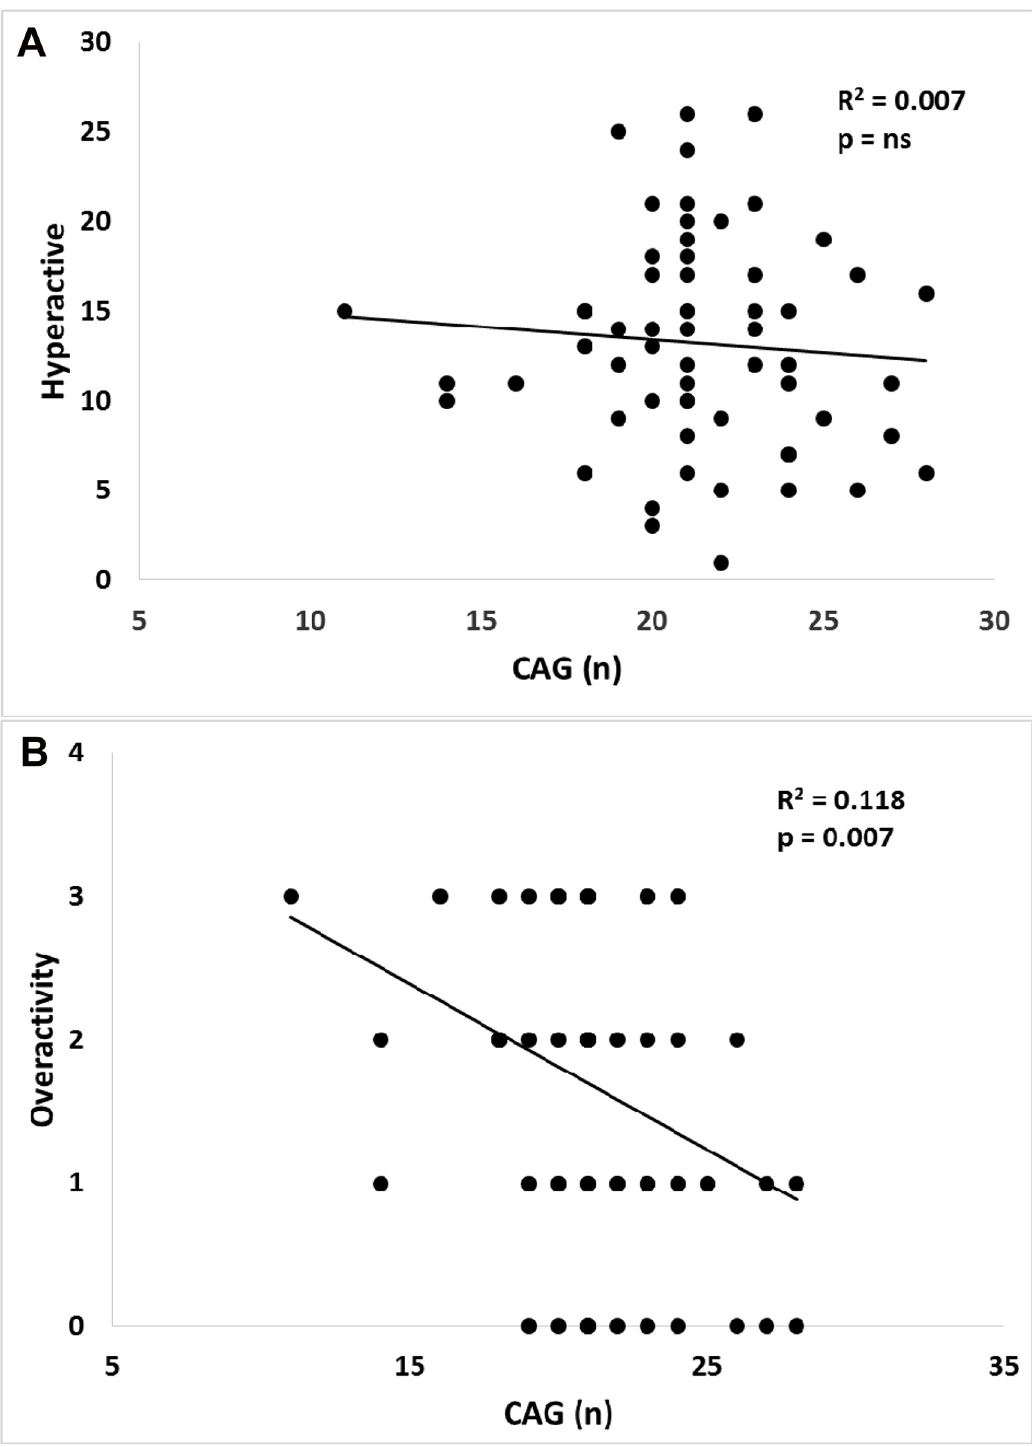
Fig 1. Correlations between CAG (n) in gene encoding AR and hyperactivity symptoms in the sample. (A) CAG (n) was not associated with total score on the hyperactivity subscale of NCBRF (R 2 = 0.007, p = ns) (B) CAG (n) was significantly negatively correlated with the overactivity score on ADOS-2 (R 2 = 0.118, p =